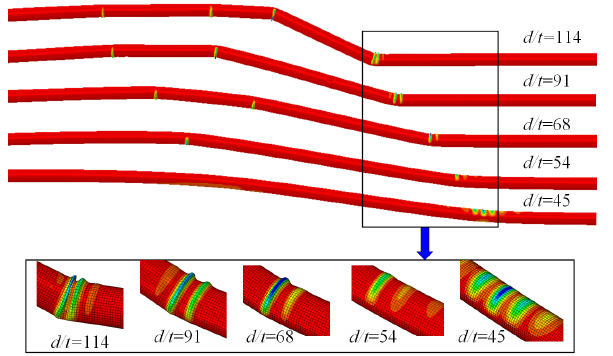
Figure 11. Buckling behaviors of the buried pipeline under differ- ent diameter-thick